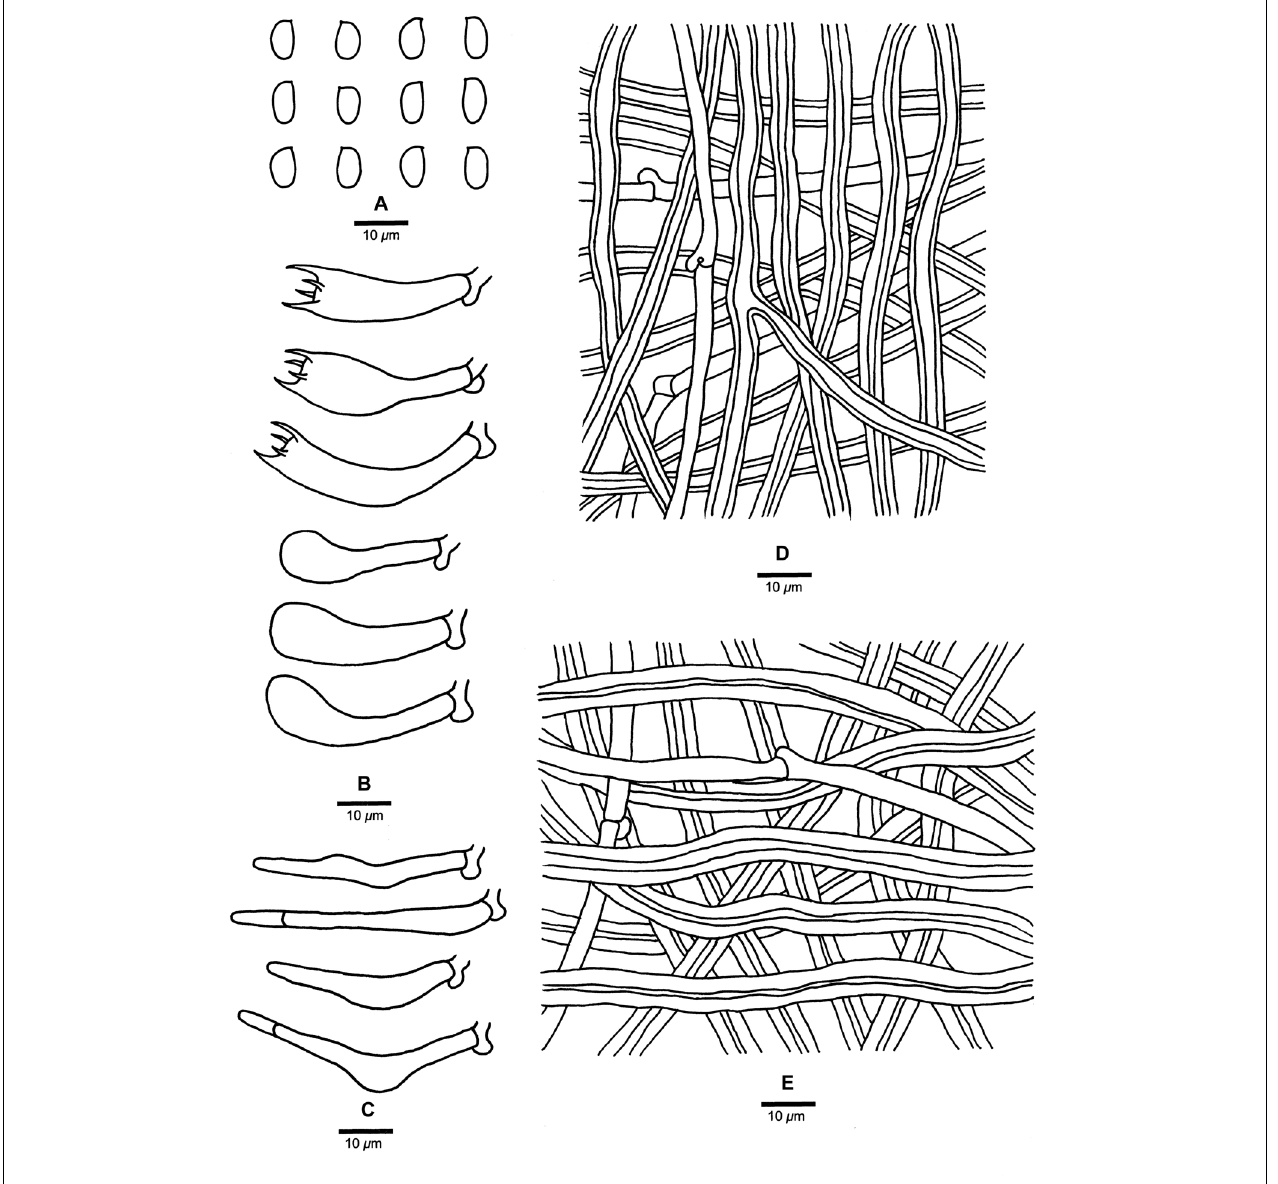
FIGURE 4 | Microscopic structures of Fomitopsis abieticola (drawn from the holotype). (A) Basidiospores; (B) Basidia and basidioles; (C) Cystidioles; (D) Hyphae from trama; (E) Hyphae from context. Bars: A–E = 10 µ